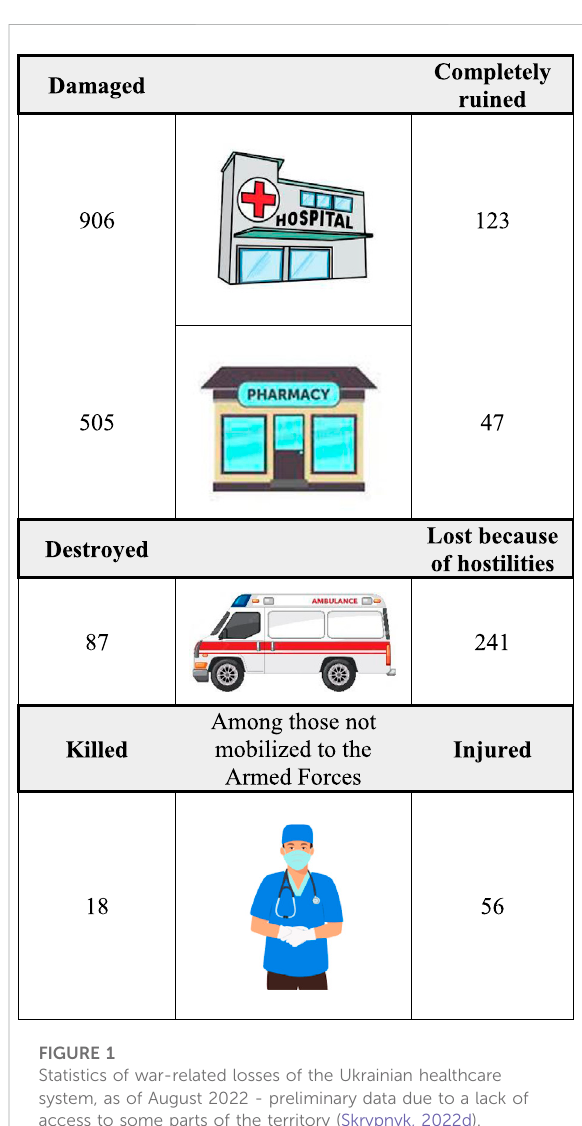
FIGURE 1 Statistics of war-related losses of the Ukrainian healthcare system, as of August 2022 - preliminary data due to a lack of access to some parts of the territory (Skrypnyk,